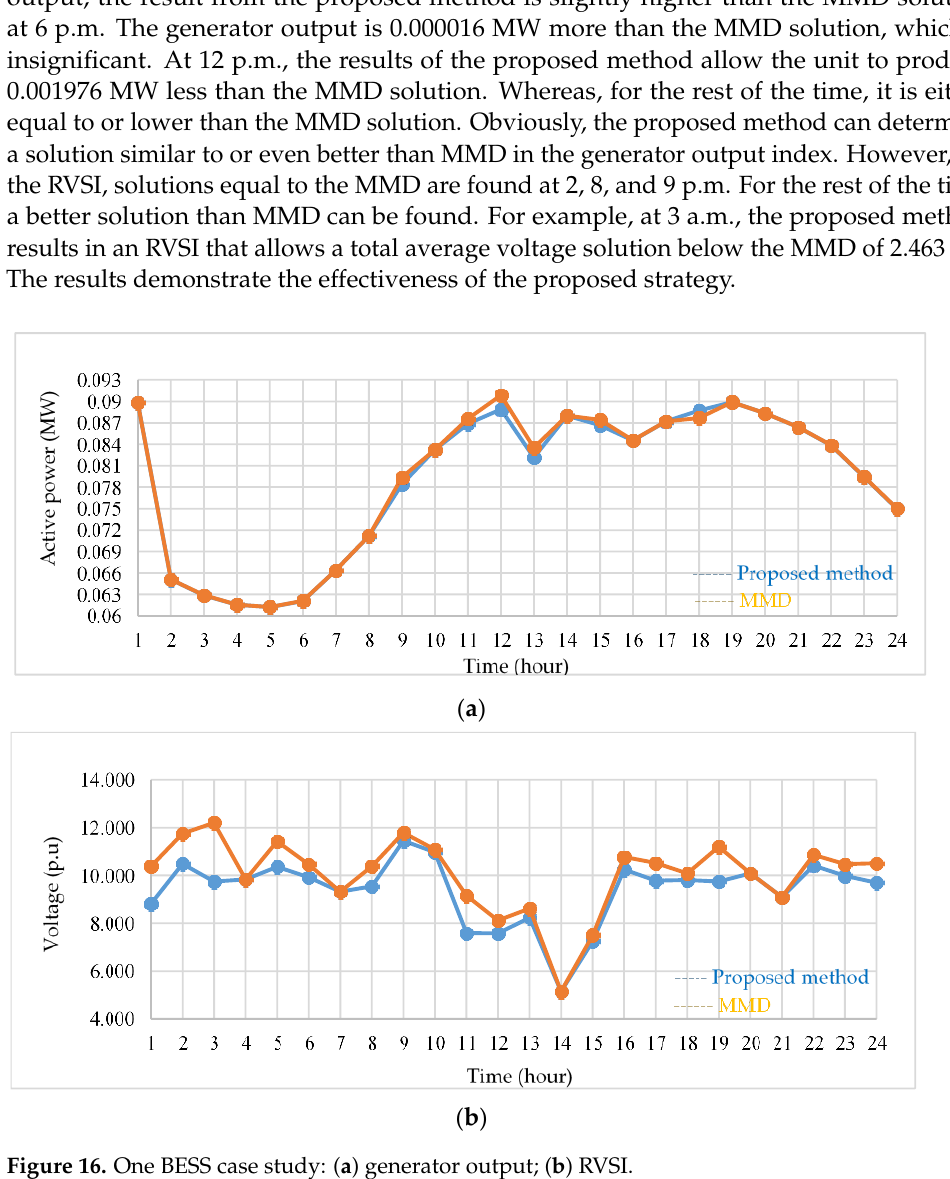
Figure 16. One BESS case study: ( a ) generator output; ( b )